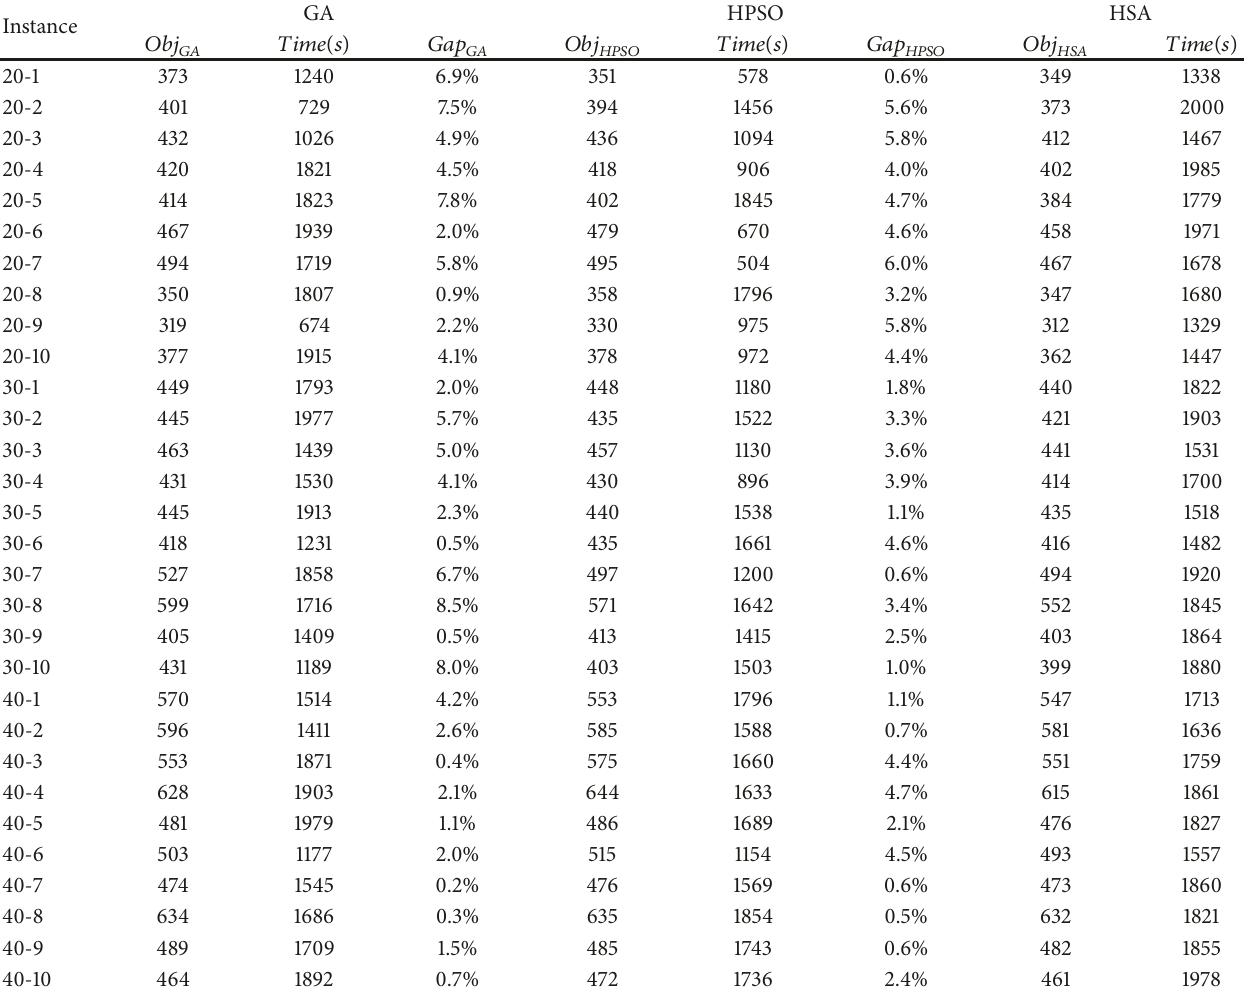
Table 5: Numerical comparison between the heuristics for large instances.